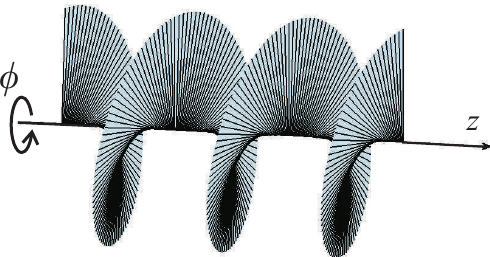
Figure 4. An optical wavefront with nonzero OAM. The phase factor of the wave, e il φ , depends on the azimuthal angle φ , giving the surfaces of constant phase a characteristic corkscrew shape that clearly exhibits winding about the point of the plane penetrated by axis of propagation, z . The Poynting vector, (cid:126) S is perpendicular to the wavefront at all points, rotating as the wave propagates along the z